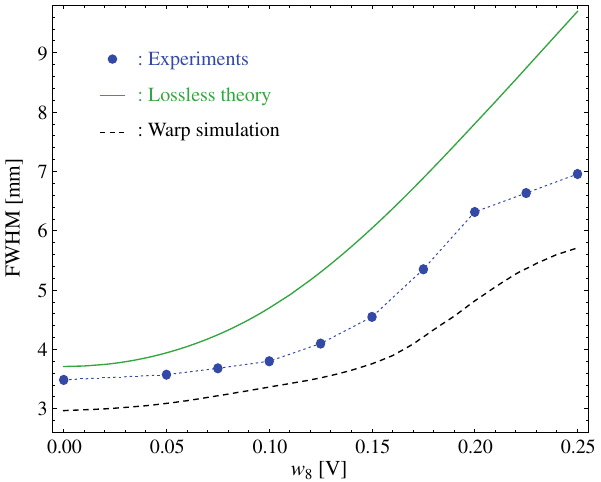
FIG. 7. Measured growth in horizontal FWHM as a function of perturbation strength w 8 calculated from integrated phosphor screen images. The tune is set to ν 0 ¼ 8 . 1 , and the dipole perturbation is excited at the eighth